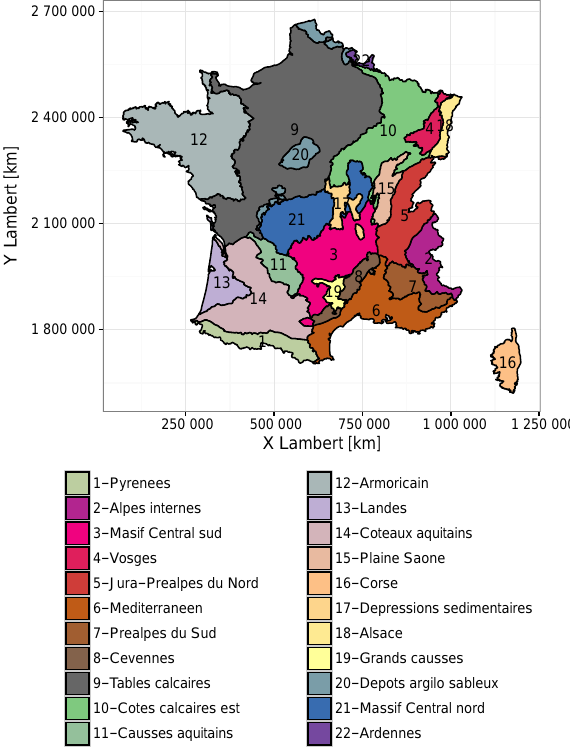
Figure C1. Map of the 22 hydro-ecoregions, adapted from Wasson et al.